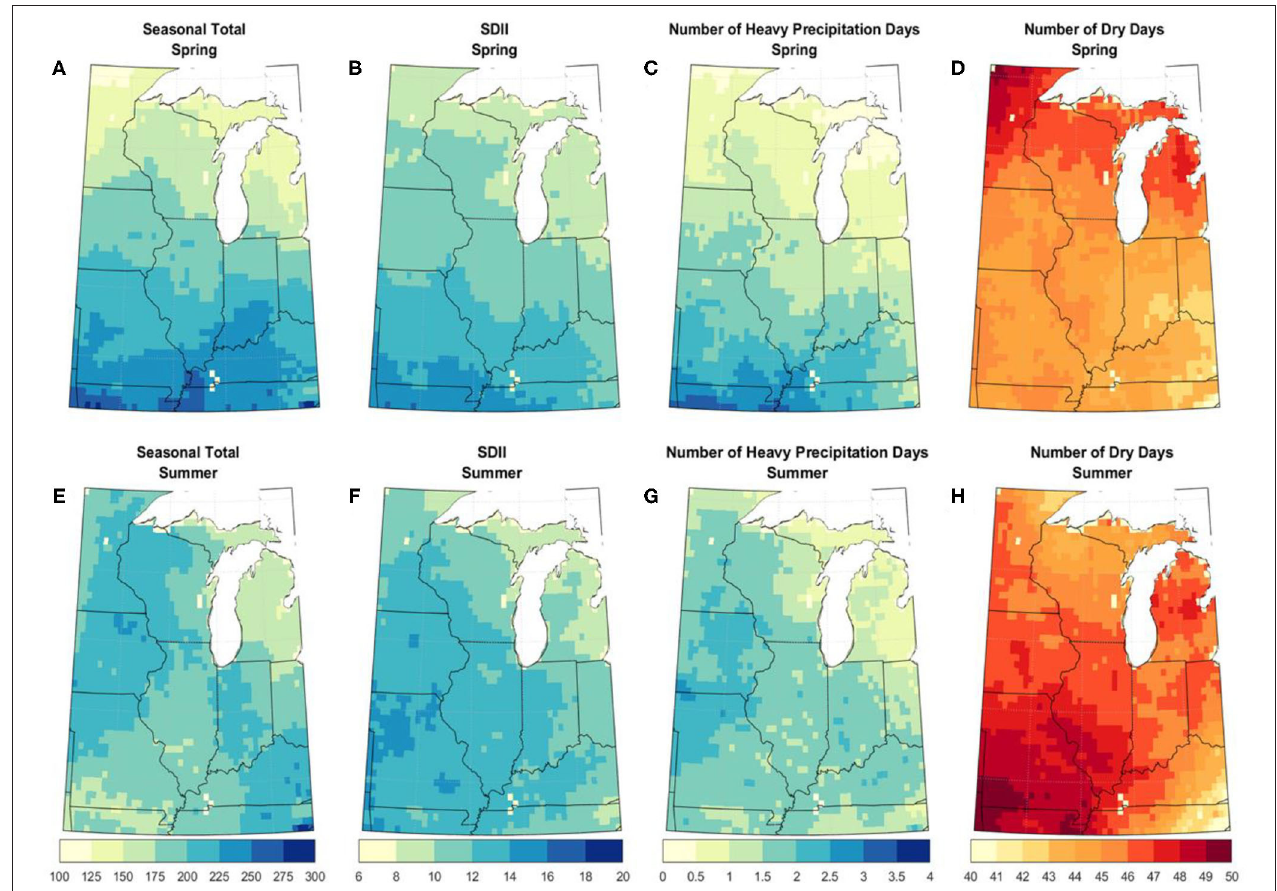
FIGURE 1 | The upscaled NClimDiv spring and summer climatology for the seasonal precipitation totals [ (A,E) , mm], SDII [ (B,F) , mm day − 1 ], seasonal number of heavy precipitation days [ (C,G) , days], and seasonal number of dry days [ (D,H) , days] for the historical period 1951–2005.